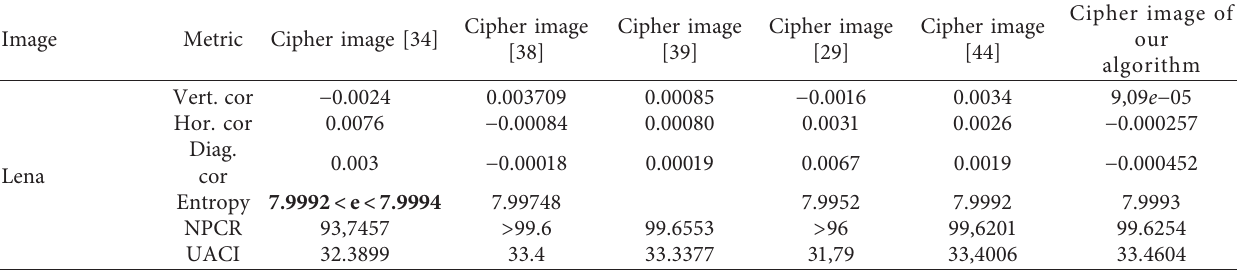
Table 12: Comparison of results on nonmedical